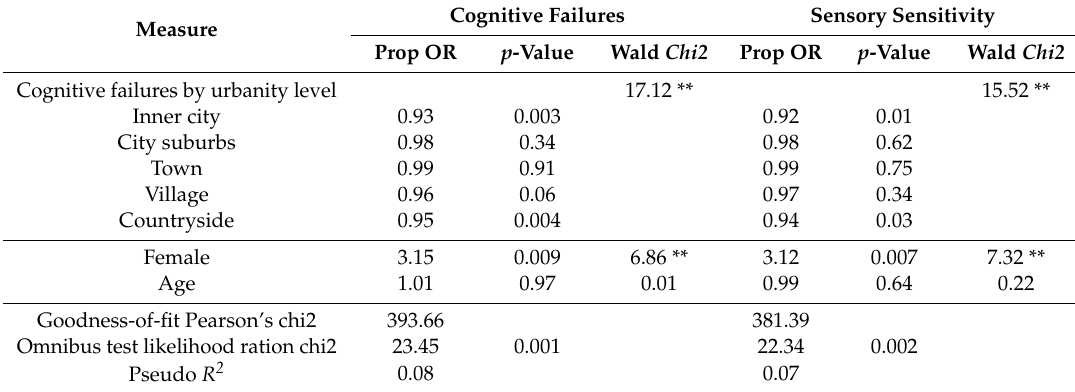
Table 2. Preference for the Presence of People based on Cognitive / Sensory Measures and Urbanity Level. Cognitive Failures Sensory Sensitivity Measure Prop OR p -Value Cognitive failures by urbanity